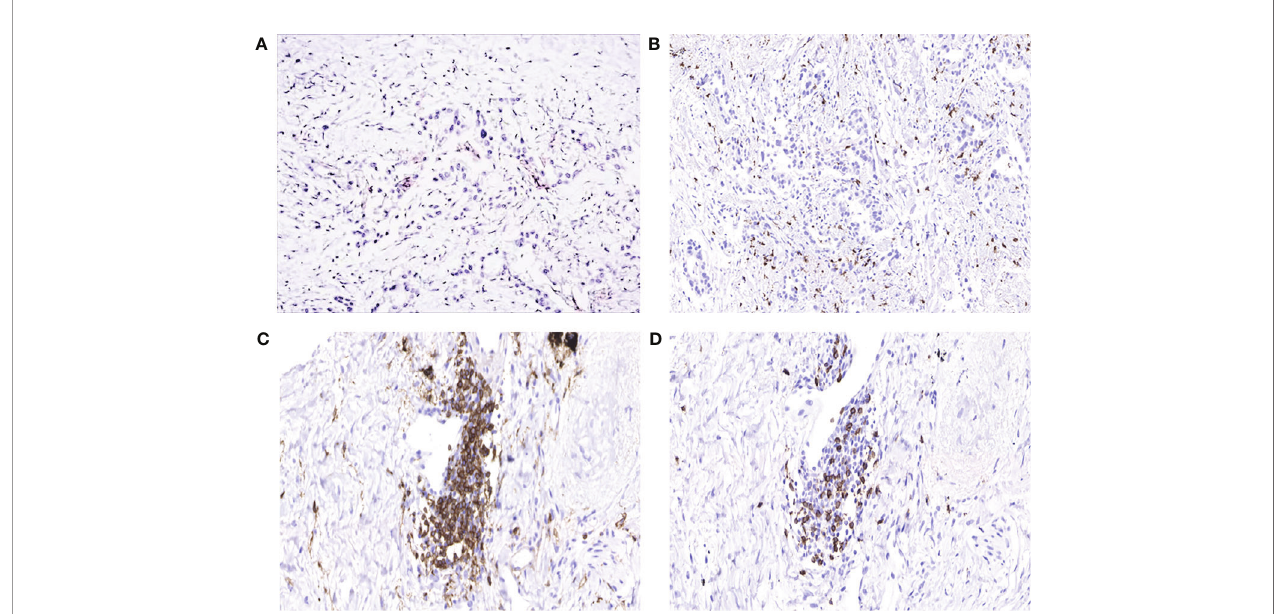
FIGURE 4 | (A) Programmed death-ligand 1 (PD-L1) tumor proportion score (TPS) <1%. (B) High in fi ltration of CD8 + tumor-in fi ltrating lymphocytes (TILs). (C) Presence of large numbers of CD4 + T cells in the stroma of the tumor. (D) Presence of large numbers of CD8 + T cells in the stroma of the